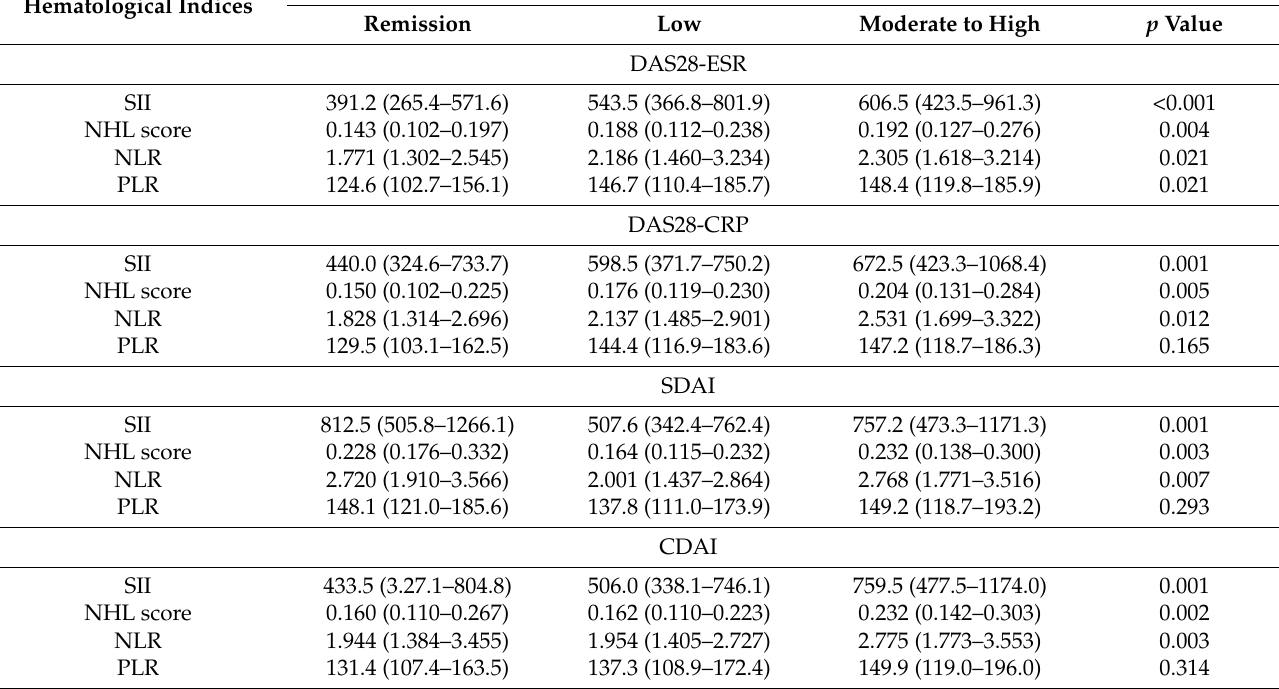
Table 4. Comparison of the differences in hematological indices among disease activity subgroups based on composite